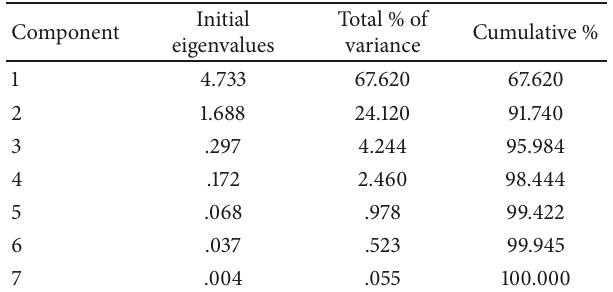
Table 5: Rotated component matrix.